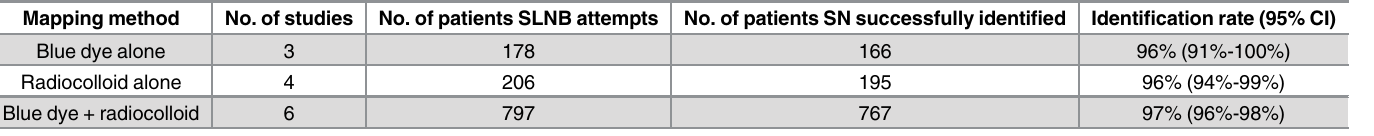
Table 3. Identification rate of SLNB according to mapping method. Mapping